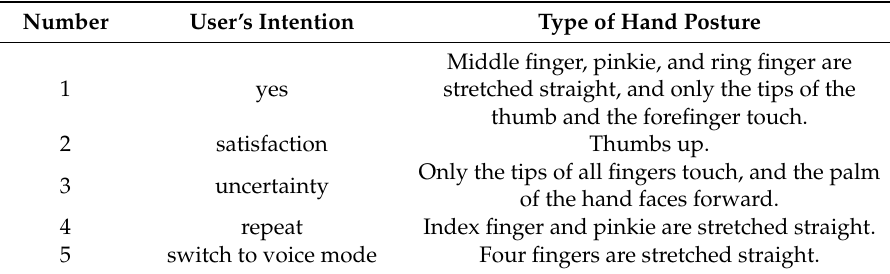
Table 3. Mapping the confirmation of user